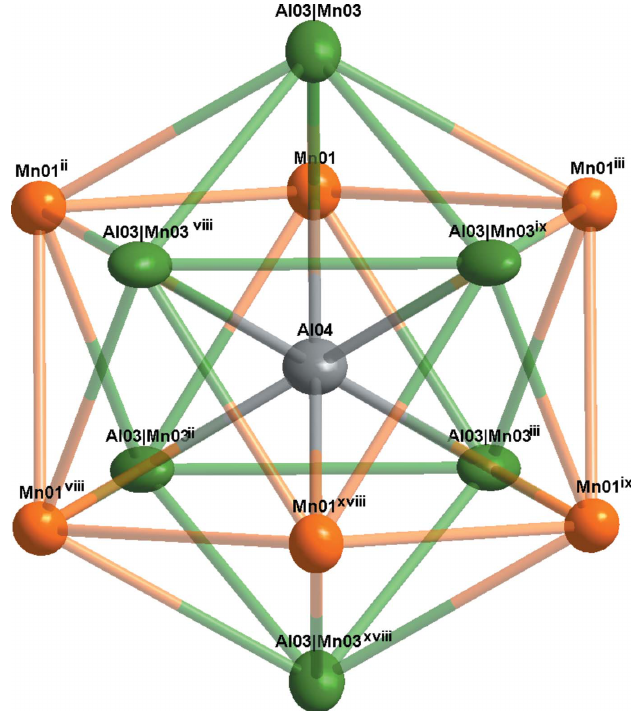
Figure 3 The environment of the Al04 atom. Displacement ellipsoids are given at the 90% probability level. Symmetry codes: (ii) x (cid:3) y + 1 (iii) y +